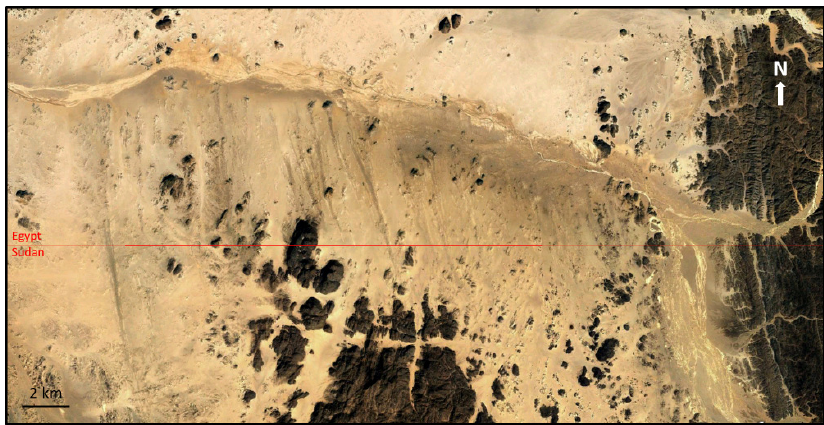
Figure 7. The Wadi El-Allaqi Dune Field. Source: Google Earth image © 2019 CNES/Airbus.